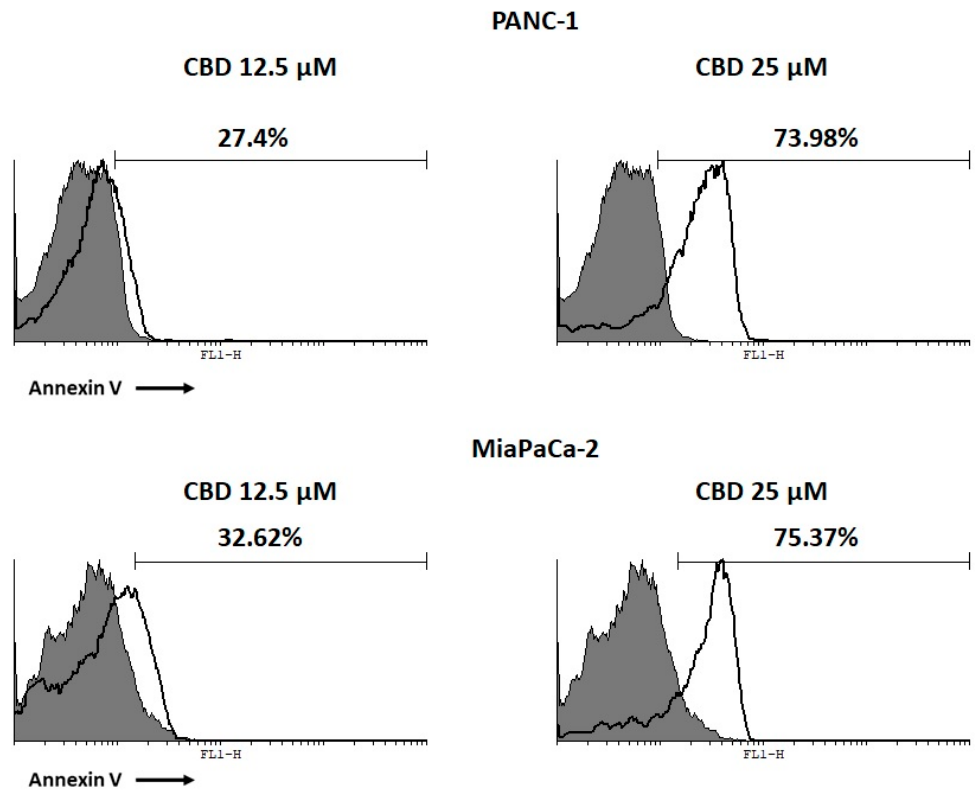
Figure 2. CBD induced cell death in pancreatic ductal adenocarcinoma (PDAC) cell lines. PDAC cell lines were treated with CBD for 48 h. Flow cytometric analysis was performed by Annexin V / Propidium Iodide (PI) staining. Data represent the percentage of Annexin V positive cells and are representative of one of three separate